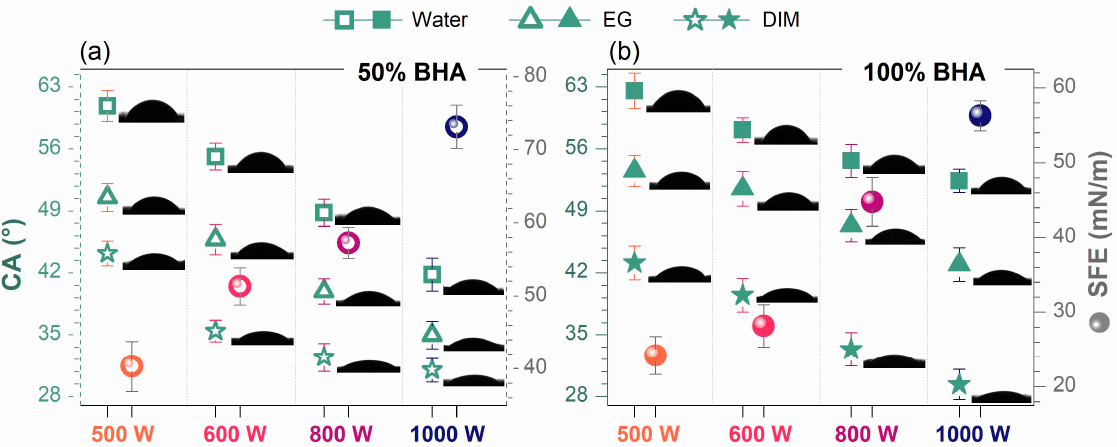
Figure 5. Contact angle measurements with three wetting agents (water, diiodomethane (DIM), and ethylene glycol (EG)), and Surface Free Energy (SFE) determined by the OWRK method, of the laser-cladded samples deposited using BHA powder contents of ( a ) 50 and ( b ) 100 wt.% at the four beam powers.